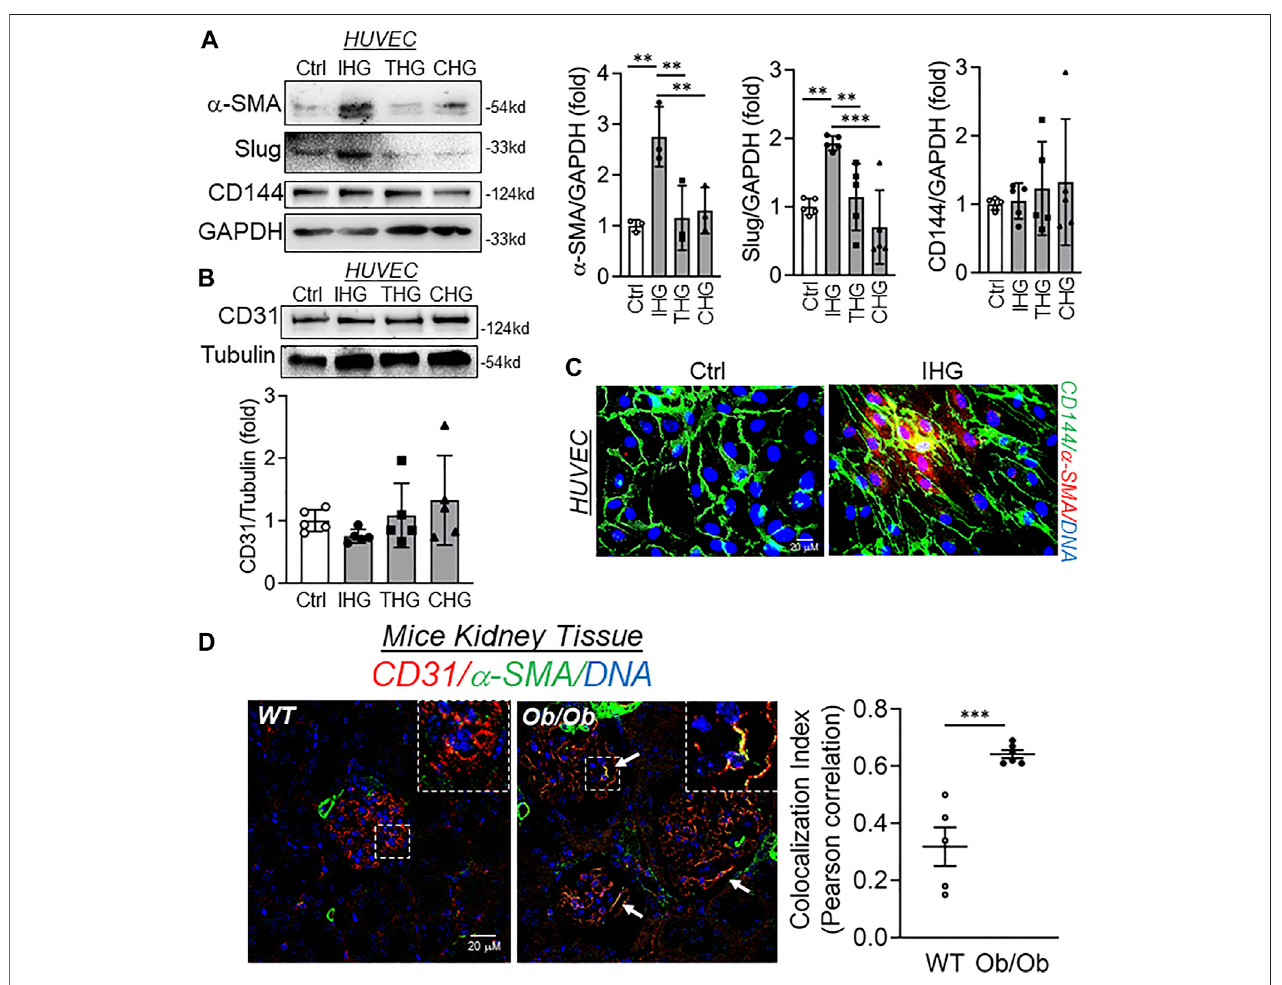
FIGURE 1 | Intermittent high glucose imparts mesenchymal character in endothelial cells both in vitro and in vivo . (A , B) Immunoblot analysis of HUVEC lysates collected from cells treated with differential high-glucose treatment conditions and probed for α -SMA ( A , n = 3), Slug ( A , n = 5), CD144 ( A , n = 5), and CD31 ( B , n = 5) along with their respective densitometry quanti fi cation analysis. (C) Immuno fl uorescence analysis and costaining of HUVEC exposed to intermittent high glucose for α - SMA and CD144. DAPI staining to visualize the nucleus is shown in blue ( n = 3). (D) Immunohistochemistry of tissue sections from BTBR WT and BTBR Ob/Ob micestainedfor α -SMAandCD31( n =3).DAPIstainingisshowninblue.Imageswereacquired withZeissLSM780Microscope.Whitearrowheadsindicateendothelial cellsexpressingbothCD31and α -SMA.DegreeofcolocalizationwasanalyzedusingtheColoc2pluginofImageJandPearsoncorrelationcoef fi cientvalueswereplotted to indicate the level of colocalization between CD31 and α -SMA. Values represent the mean ± SD. ** p < .01, and *** p < .001, either by unpaired t -test for two groups or the two-stage linear step-up procedure of Benjamin, Krieger, and Yekutieli test for comparisons of multiple groups.